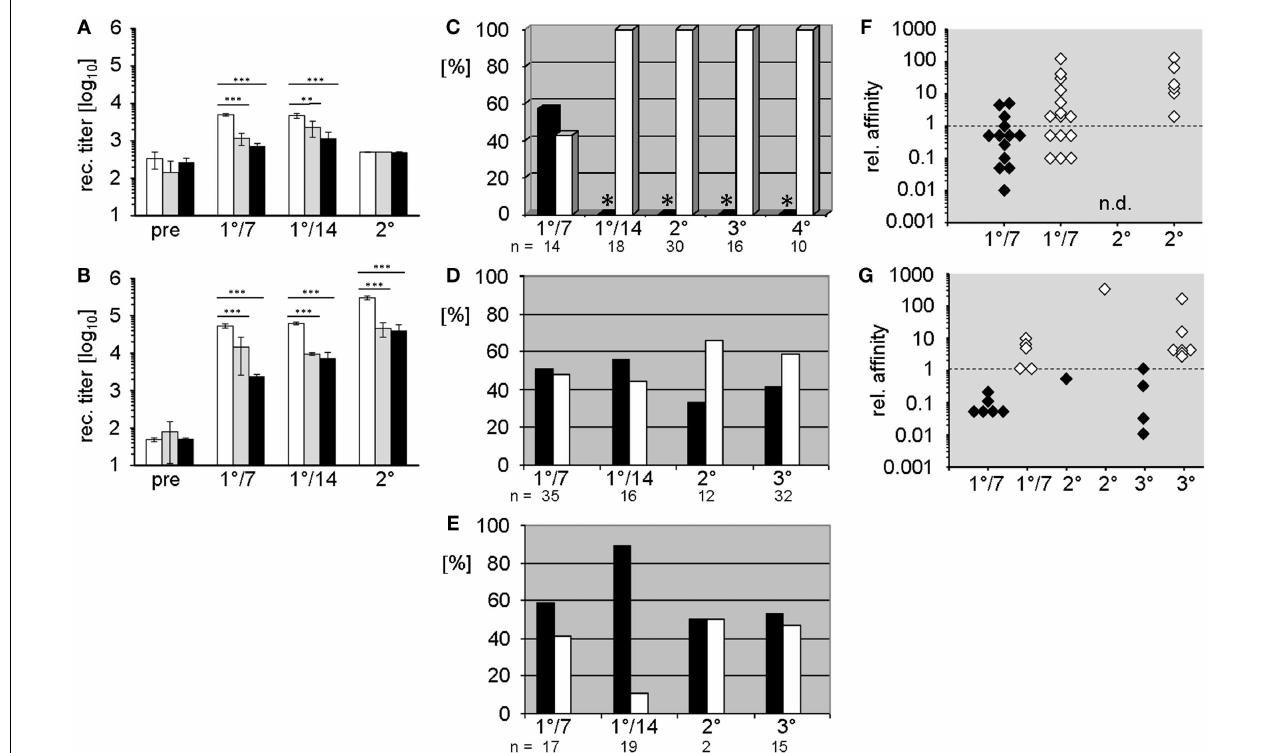
FIGURE 1 | Comparison of humoralAb responses to the hapten 2-phenyloxazolone in BALB/c wild-type and D-altered ∆ D-D µ FS and ∆ D-iD mutant mice . (A,B) IgM (A) and IgG (B) anti-phOx Ab titers of primary and secondary thymus-dependent immune responses after immunization with phOx-CSA in BALB/c wild-type mice (white bars), ∆ D-D µ FS mice (gray bars), and ∆ D-iD mice (black bars).The bars show the mean + SD of five mice per group. Pre – pre-immune sera; 1°/7 – primary day 7 and 1°/14 – primary day 14 responses. Secondary immunization followed 14weeks after primary and Ab titers were determined after two more weeks. Significance is indicated at ** p < 0.01; *** p < 0.001. (C–E) Monoclonal anti-phOx mAb were prepared from (C) BALB/c wild-type, (D) ∆ D-D µ FS, and (E) ∆ D-iD mice on day 7 (1°/7) and day 14 (1°/14)